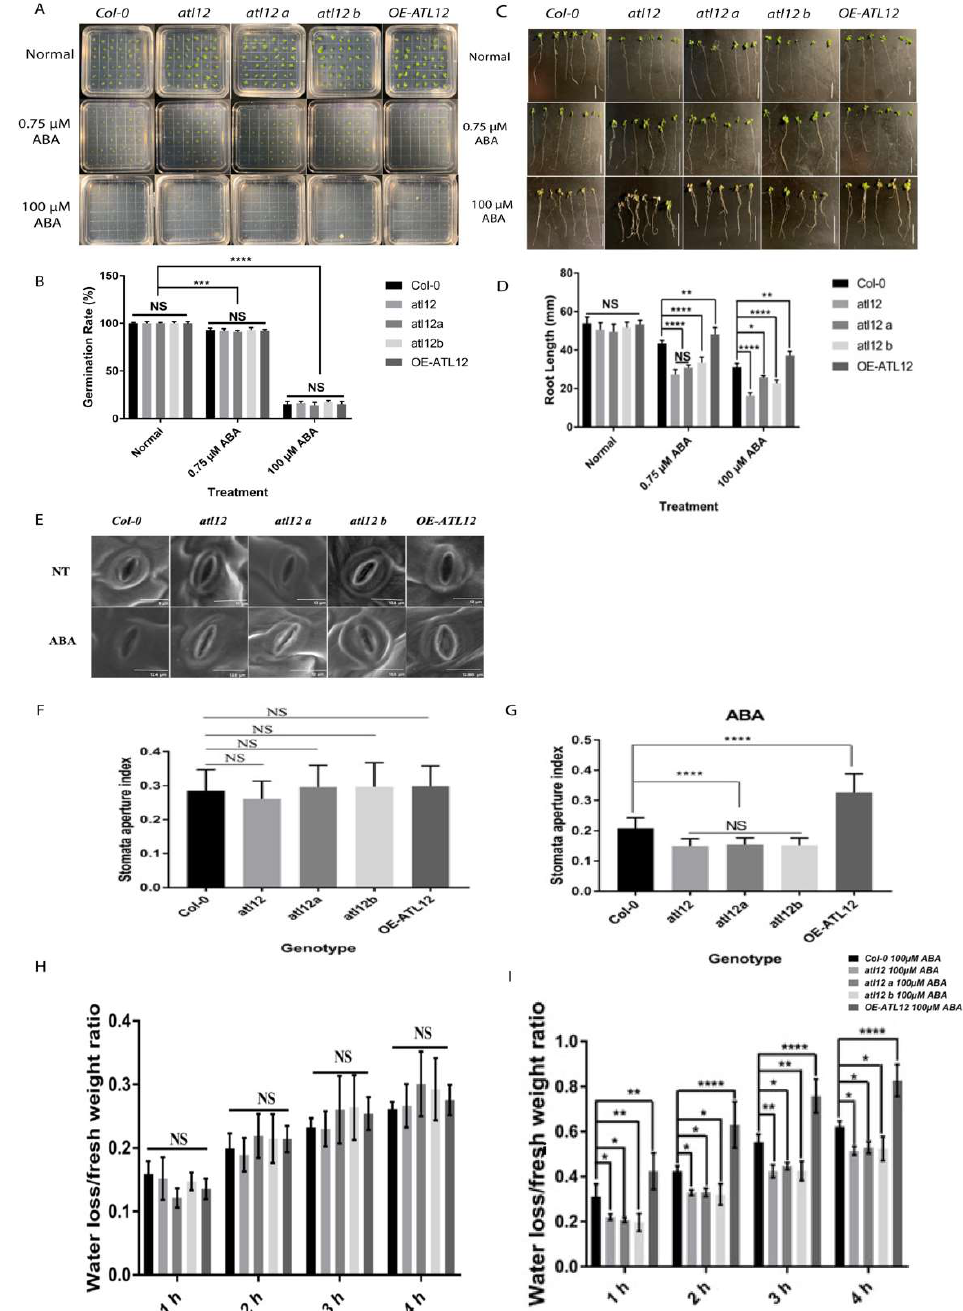
Figure 7. ATL12 modulates ABA response. ( A ) Images of Col-0 wild-type, atl12 mutants, and the overexpression line under normal, 0.75 µ M, and 100 µ M ABA contained MS agar plates. ( B ) Germination rate analysis. Error bars indicate mean ± SD of five independent experiments; ( C ) Images of Col-0 wild-type, atl12 mutants, and overexpression line root length growth under normal, 0.75 µ M, and 100 µ M ABA contained MS agar plates. ( D ) Primary root length analysis. Error bars indicate mean ± SD of five independent experiments; NS: no significance; *: p < 0.05, **: p < 0.01, ***: p < 0.001,